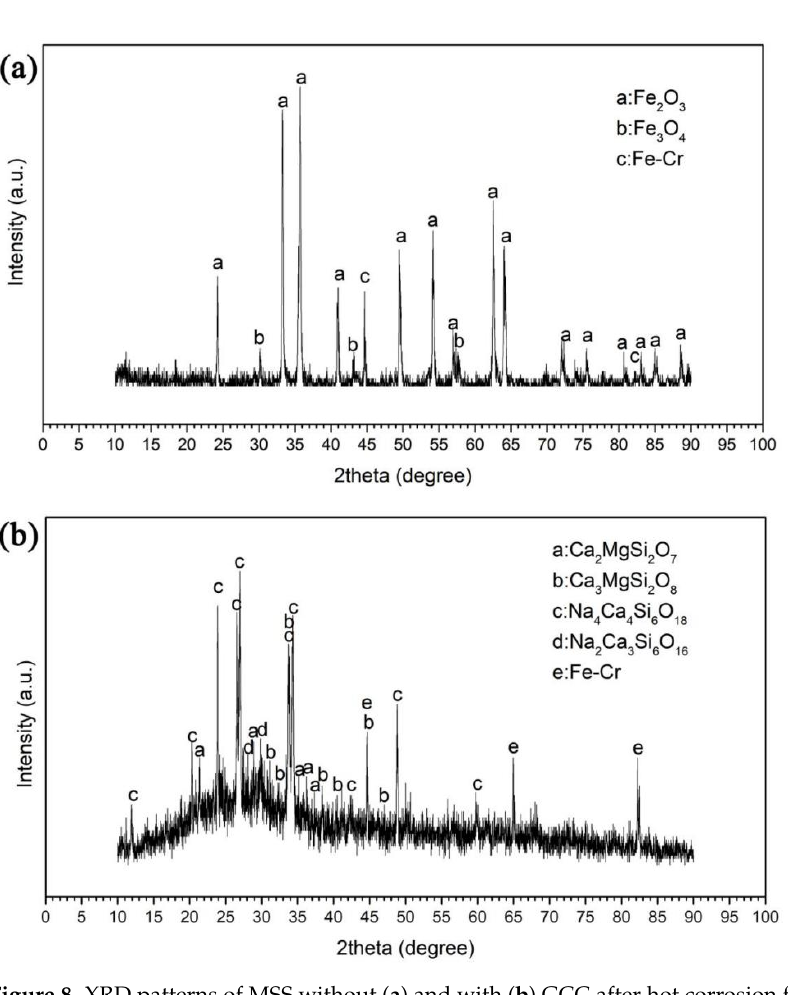
Figure 8. XRD patterns of MSS without ( a ) and with ( b ) GCC after hot corrosion for 100 h at 650 °C.